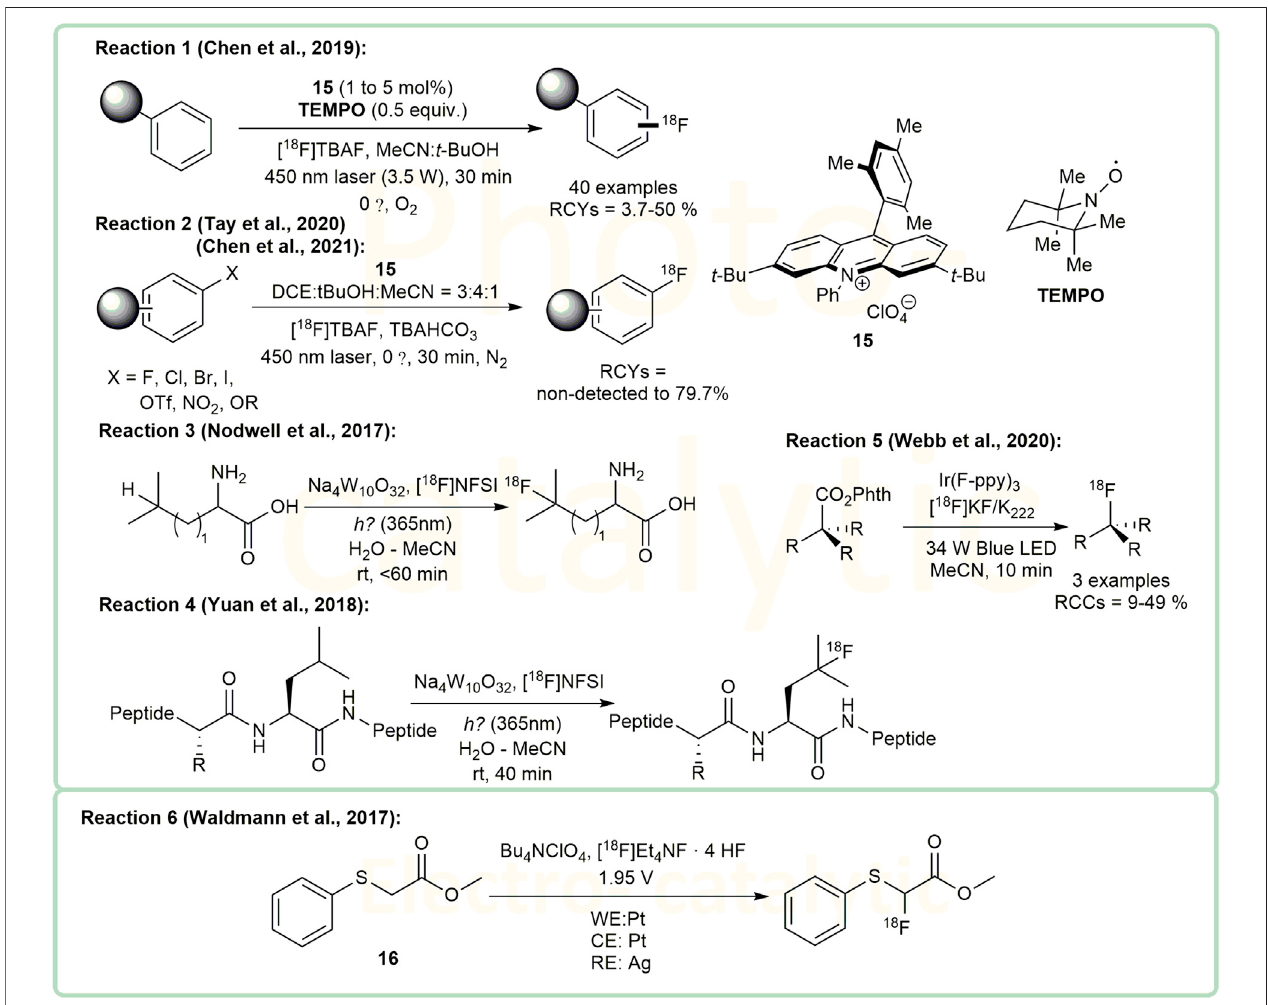
FIGURE 4 | Examples of photo- and electro-catalytic methods for radio fl uorination.